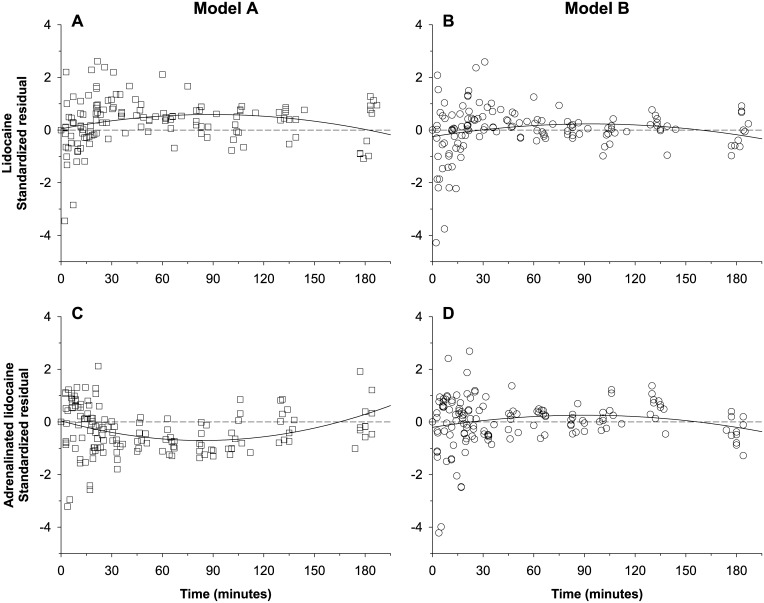
Lidocaine standardized residuals of the standard and alternative compartmental models vs. time following lidocaine administration.(A) Plain lidocaine data predicted by Model A (i.e. one first-order absorption rate per system). (B) Plain lidocaine data predicted by Model B (i.e. two asynchronous first-order absorption rates per system). (C) Adrenalinated lidocaine data predicted by Model A. (D) Adrenalinated lidocaine data predicted by Model B. A third degree polynomial curve (continuous line) has been added to highlight the trend in the residuals.